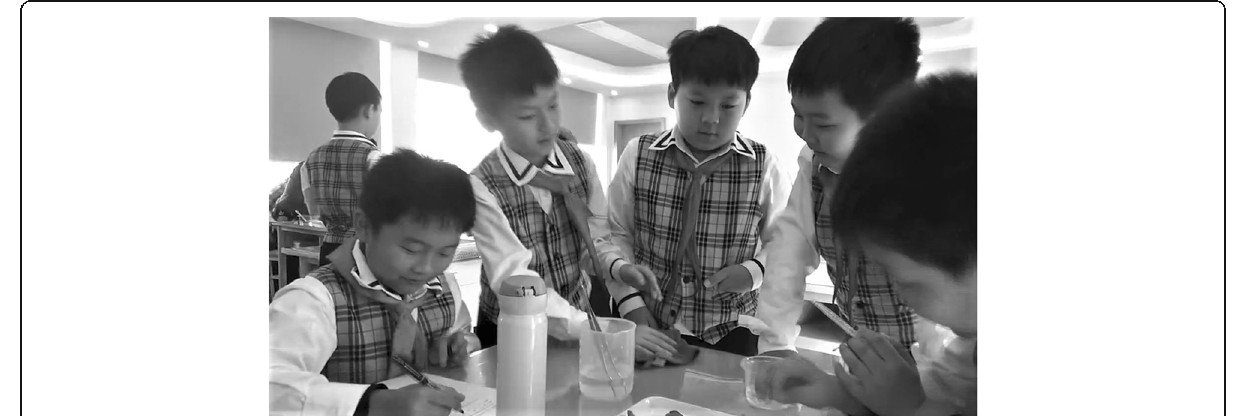
Fig. 3 At turn 2, Wang (left) is writing, and Sun (2nd left) is wiping the